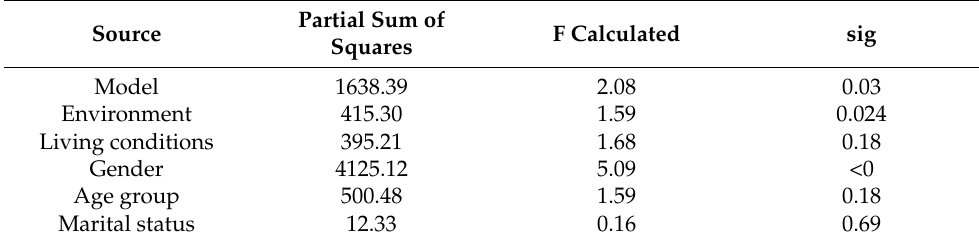
Table 5. The impact of various factors on vulnerability to stress during the COVID-19 pandemic.